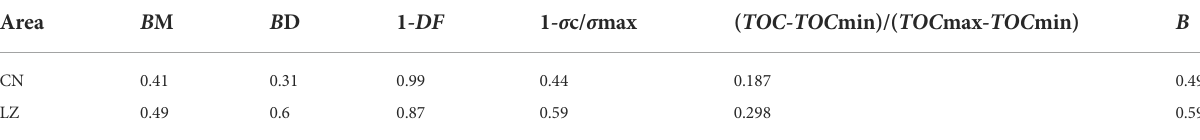
TABLE 5 Comprehensive evaluation results of fracturability of the longmaxi shale in the study area.